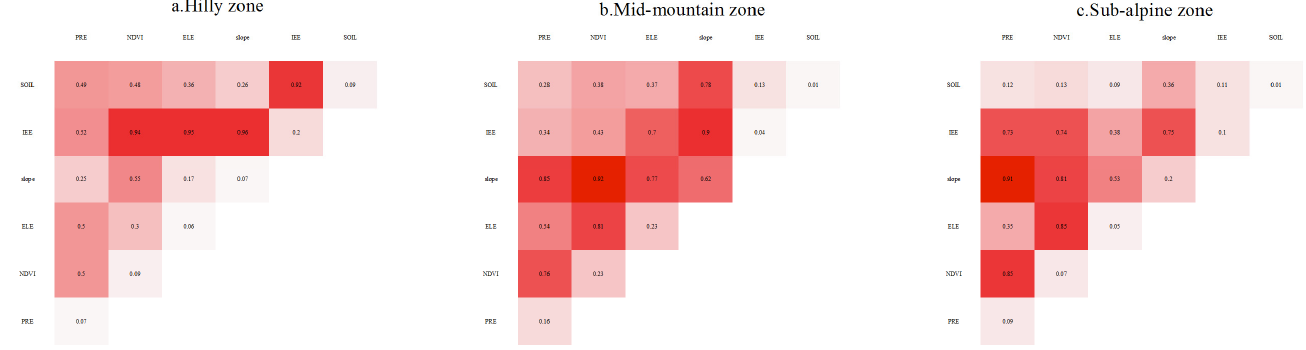
Figure 11. Statistics of q values of interaction factors in the different elevation zones.